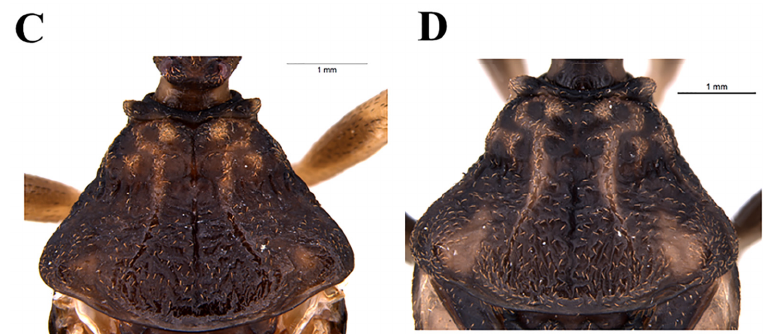
Figure 3. Detail of Head: ( A ) T. rosai sp. nov. dorsal view, ( B ) T. sordida dorsal view; detail of Pronotum: ( C ) T. rosai sp. nov. dorsal view, ( D ) T. sordida dorsal view.